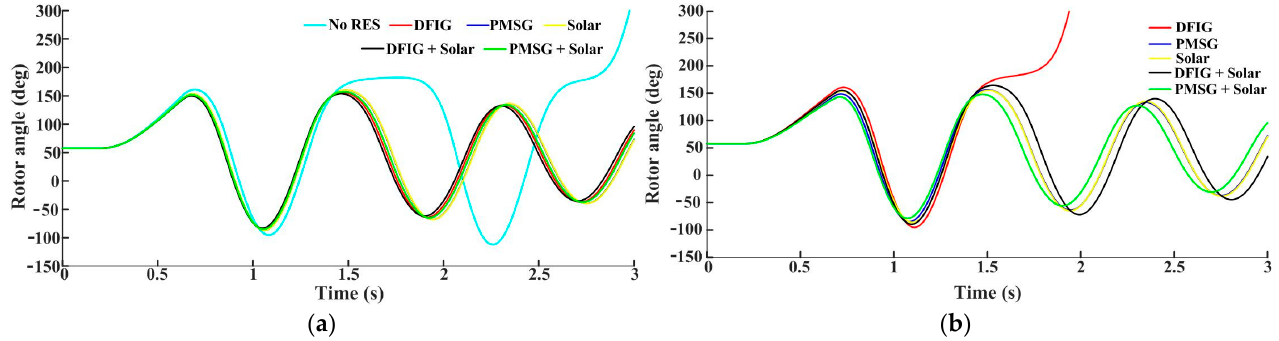
Figure 8. Variations in rotor angle ( δ 21 ) with: ( a ) conventional control and ( b ) proposed control (ARS) when the fault is at bus 5.